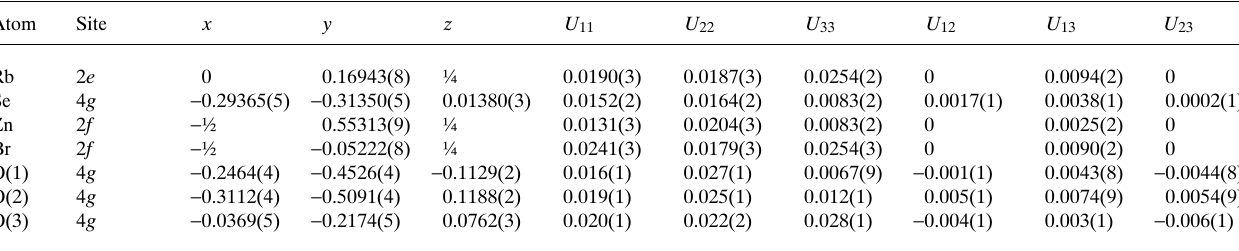
Table 6. Atomic coordinates and displacement parameters (in Å 2 ) .